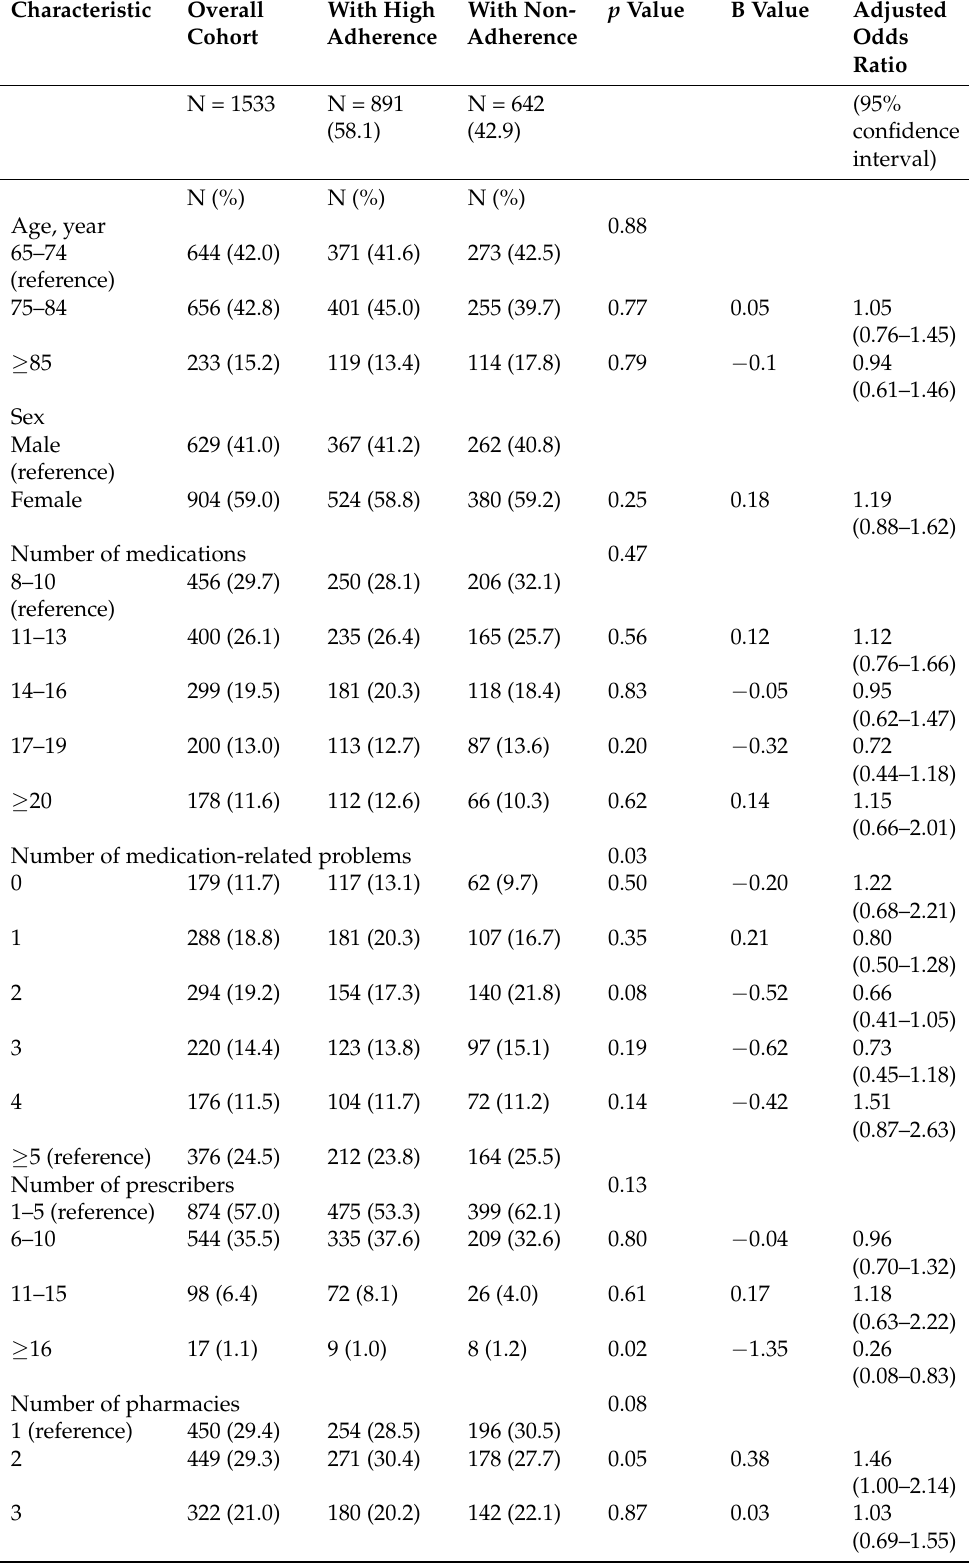
Table 2. Results from logistic regression evaluating the association between patient characteristics and adherence to controller medications in 2020 (N =